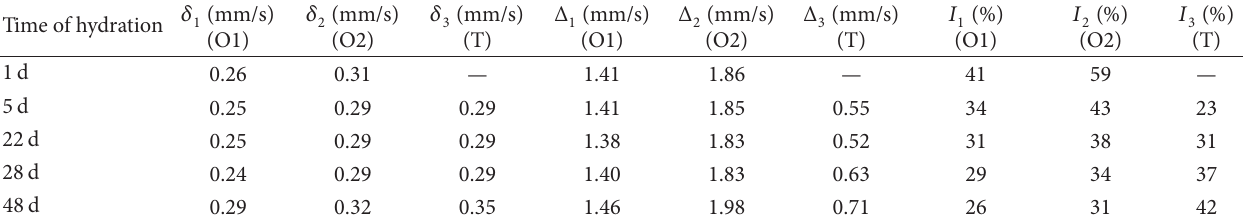
T 8: Mössbauer parameters of the of cement PC2FA at different ages of hydration. Time of